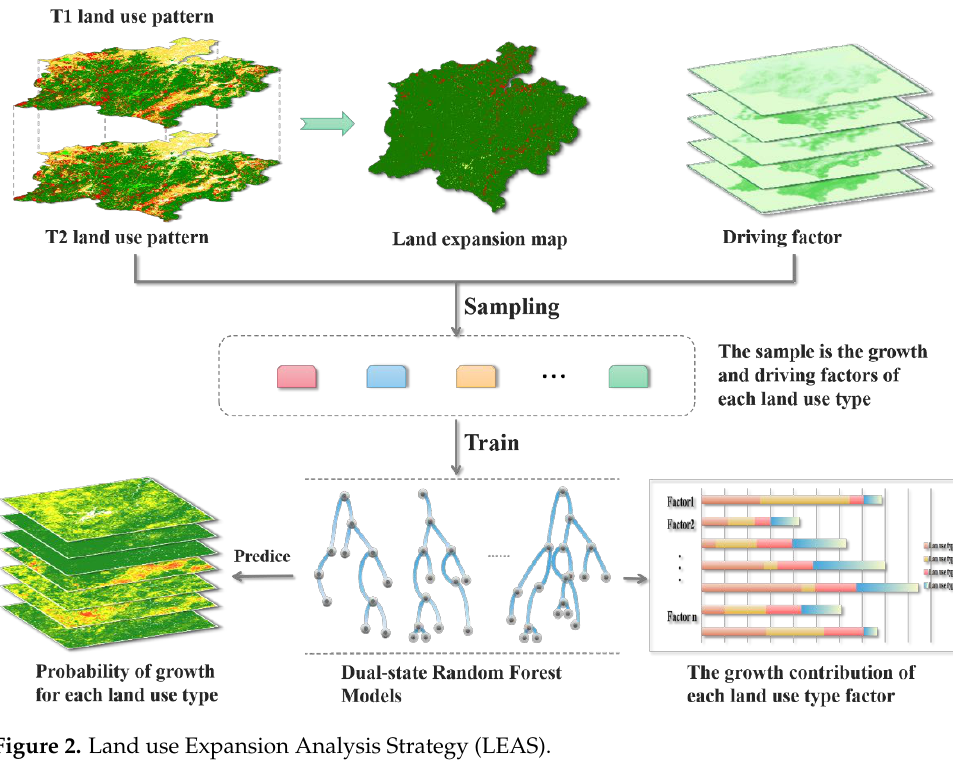
Figure 2. Land use Expansion Analysis Strategy (LEAS).